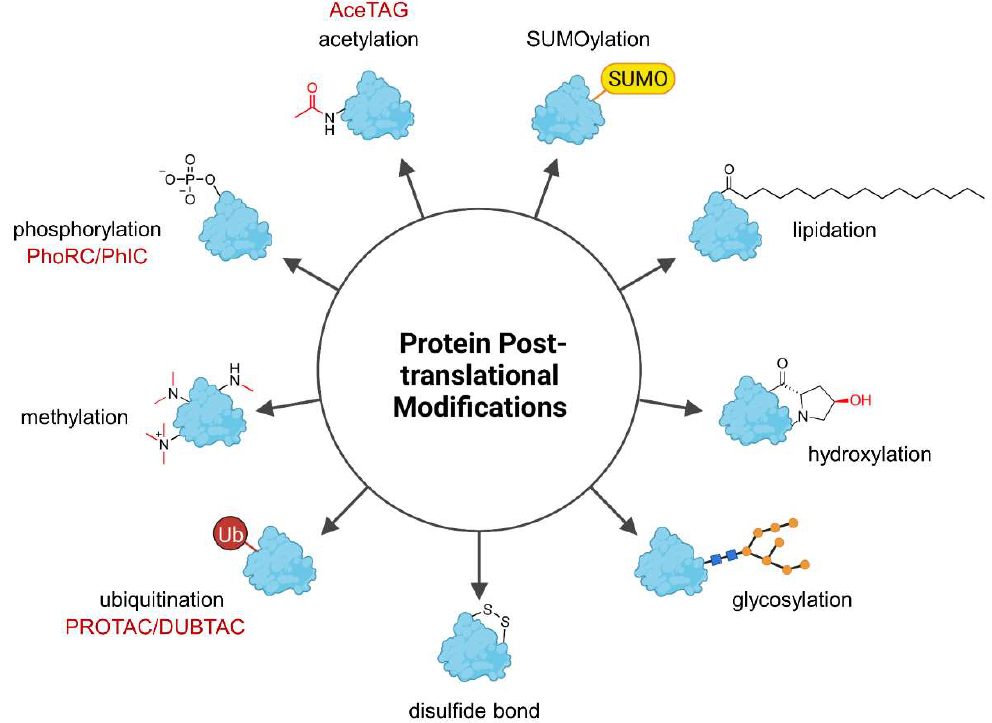
Figure 1. Overview of the most common posttranslational protein modifications (PTMs). PTMs have versatile impact on proteins and affect physicochemical properties such as hydrophilicity and overall charge as well as protein localization but they can also flag a protein for degradation (ubiquitination). Heterobifunctional molecules can precisely trigger the specific modification of their target protein, but to date only (de-)ubiquitination, (de-)phosphorylation, and acetylation have been modulated by the indicated chimeras (in red). AceTAG—acetylation-tagging system, DUBTAC—deubiquitinase-targeting chimera, PhIC—phosphorylation-inducing chimera, PhoRC— phosphatase-recruiting chimera, PROTAC—proteolysis-targeting chimera, SUMO—Small ubiquitin- related modifier,